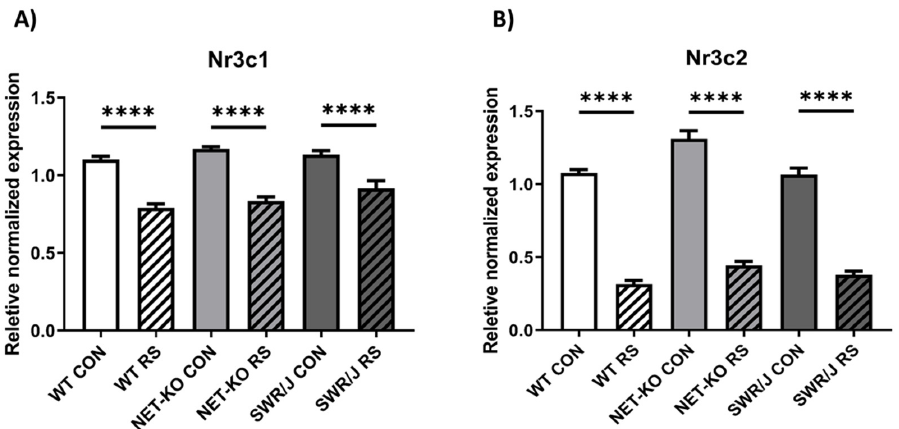
Figure 4. The expression of mRNA encoding the genes regulated by tested miRNAs in the liver of three genotypes (WT, NET-KO, SWR / J) of mice under the control condition (CON) and following stress (RS). Nuclear receptor subfamily 3, group C, member 1; glucocorticoid receptors (Nr3c1; ( A )); nuclear receptor subfamily 3, group C, member 2; mineralocorticoid receptors (Nr3c2; ( B )). **** p < 0.0001; n = 4. The significant statistical di ff erences not marked on the graphs: A) WT CON vs. NET-KO RS p < 0.0001; WT CON vs. SWR / J RS p ≤ 0.001; NET-KO CON vs. WT RS p < 0.0001; NET-KO CON vs. SWR / J RS p < 0.0001; SWR / J CON vs. WT RS p < 0.0001; SWR / J CON vs. NET-KO RS p < 0.0001; WT RS vs. SWR / J RS p ≤ 0.05; B) WT CON vs. NET-KO CON p ≤ 0.001; WT CON vs. NET-KO RS p < 0.0001; WT CON vs. SWR / J RS p < 0.0001; NET-KO CON vs. SWR / J CON p ≤ 0.001; NET-KO CON vs. WT RS p < 0.0001; NET-KO CON vs. SWR / J RS p < 0.0001; SWR / J CON vs. WT RS p < 0.0001; SWR / J CON vs. NET-KO RS p <